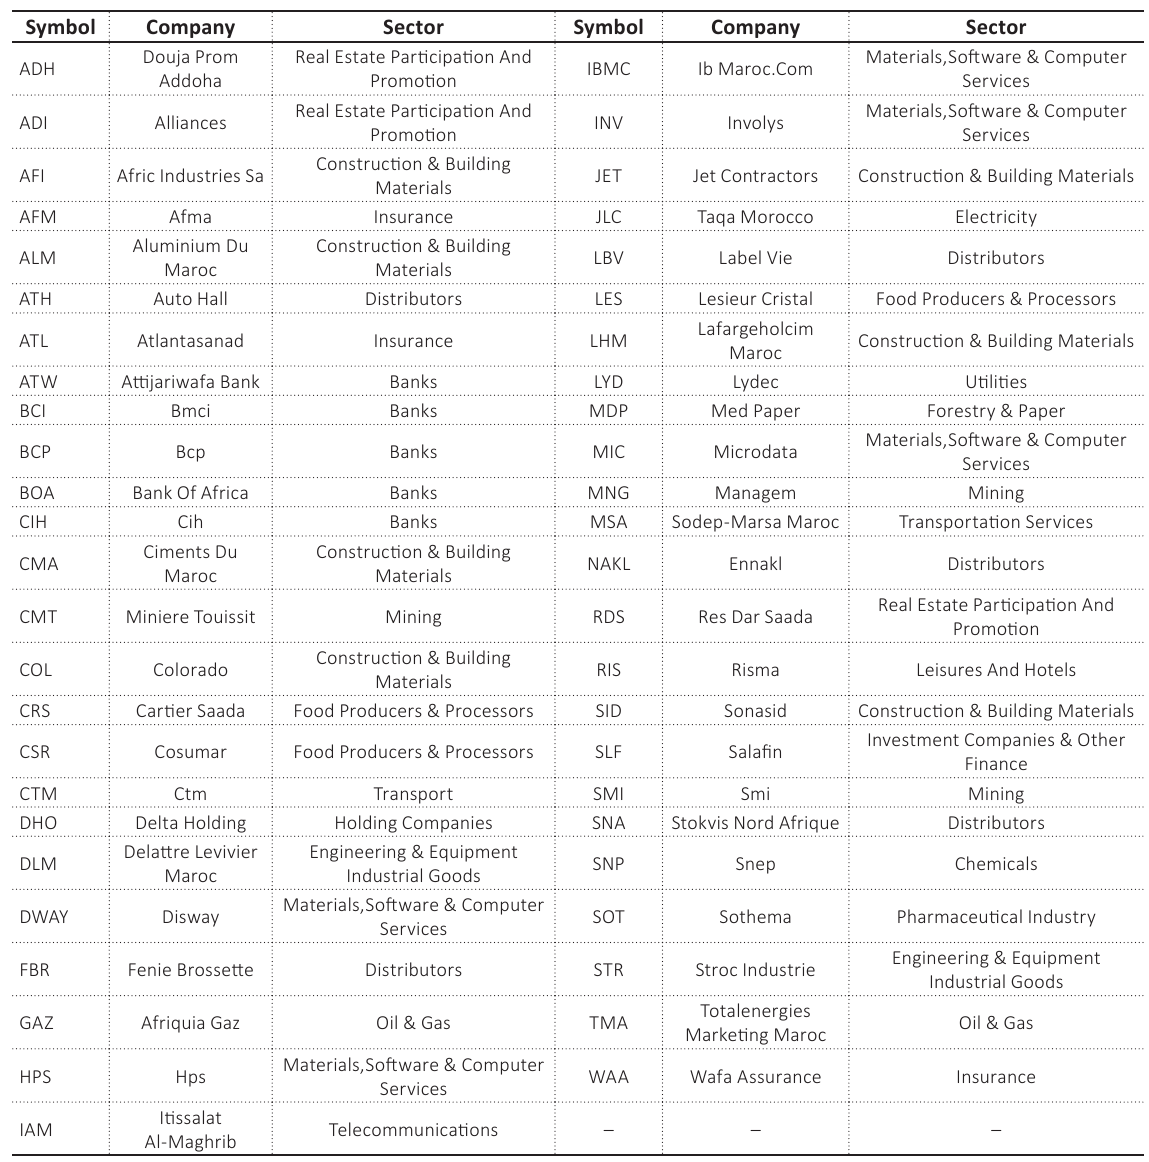
Table A1. The company’s tick symbols, names, and corresponding sectors of the 49 stocks listed on the MADEX